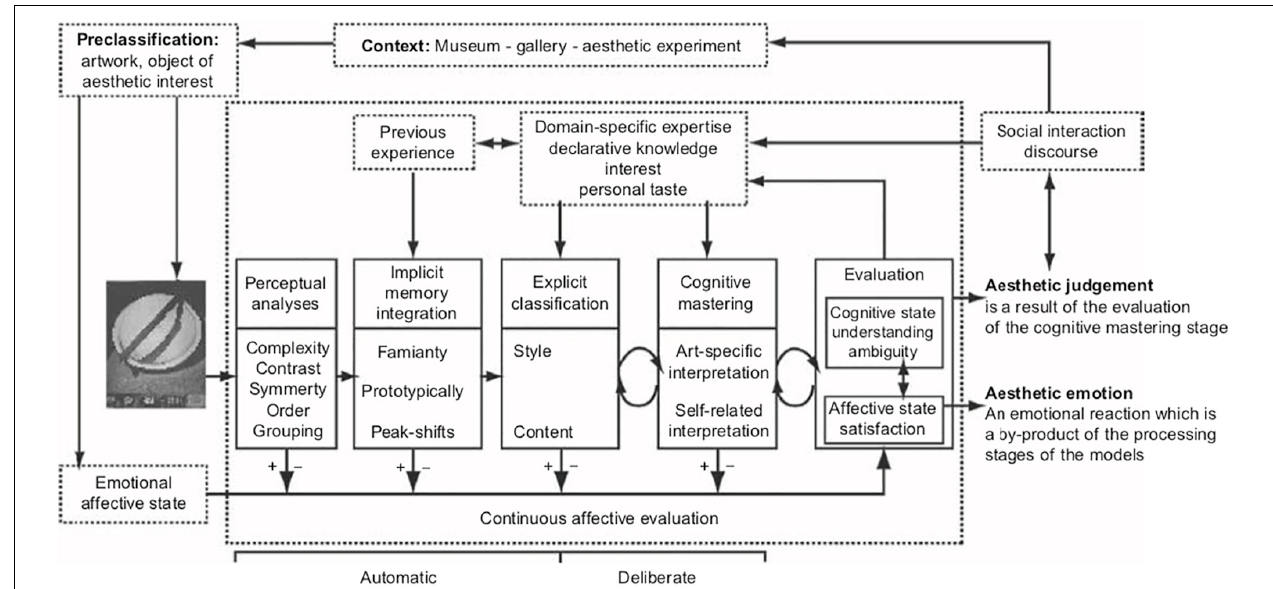
FIGURE 1 | Taken from Leder et al. (2004): A model of aesthetic appreciation and aesthetic